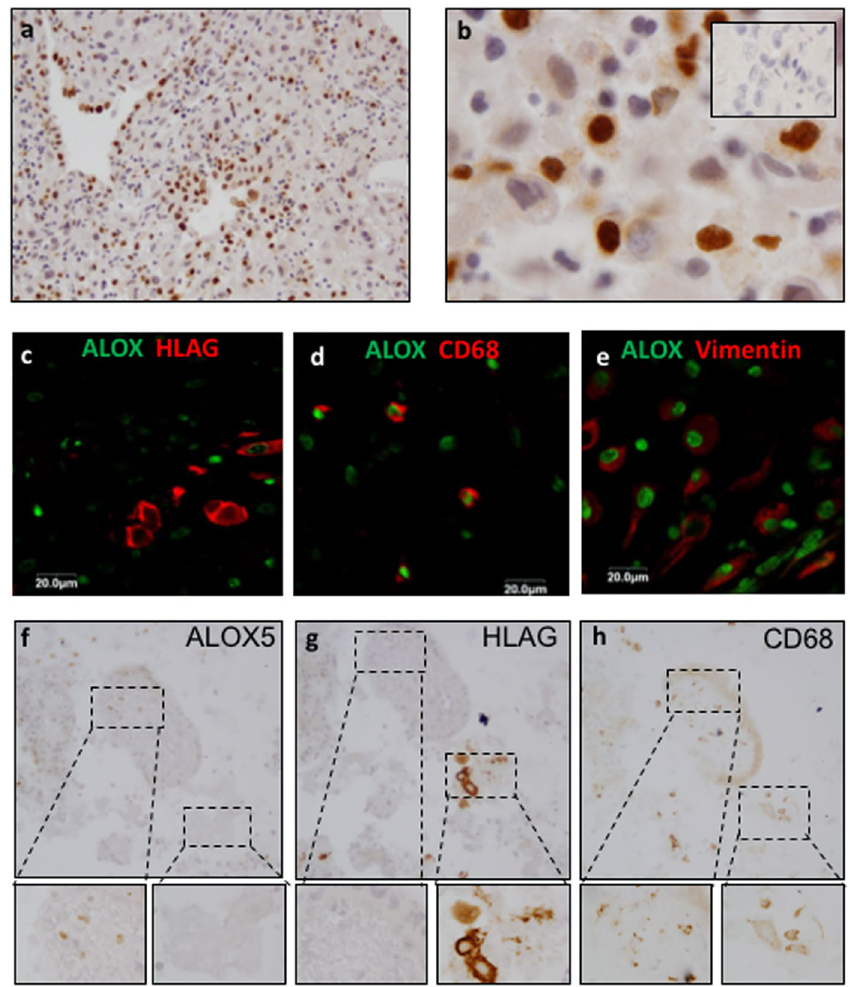
Figure 3. ALOX5 inmmunolocalization in first trimester decidua. ( a–b) ALOX5 showed nuclear staining in first trimester decidua basalis. ( c–e) Immunoflorescence showed ALOX5 did not co-localize with ( c ). HLAG (EVT marker) but did co-localize with ( d ). CD68 (macrophage marker) and ( e ). Vimentin (HESC marker). ALOX5 - green, CD68, Vimentin and HLAG – red. ( f–h ) Serial sections of first trimester decidua basalis showing that ALOX5 ( f ) was not present in tissue surrounding EVTs (determined by presence of HLAG; ( g ). The presence of macrophages in this tissue was confirmed by CD68 staining ( h ). Insert shows negative control